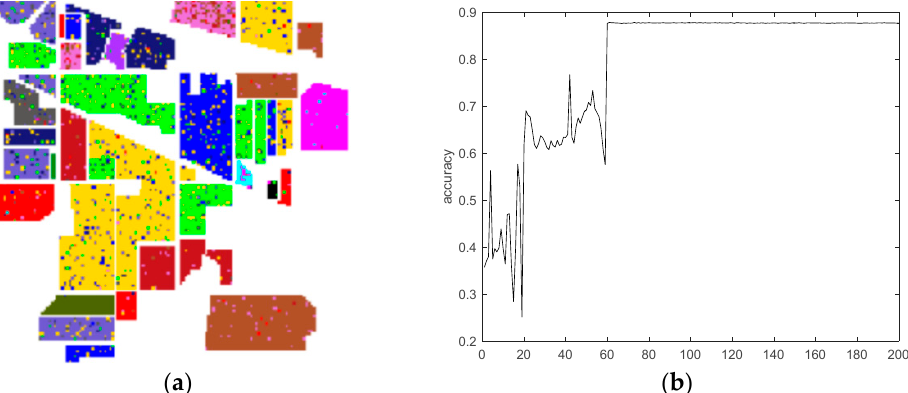
Figure 10. ( a ) Traditional CNN classification results. ( b ) Traditional CNN classification accuracy results.